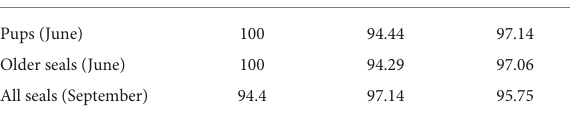
TABLE 1 Statistics from the automatic seal detecting